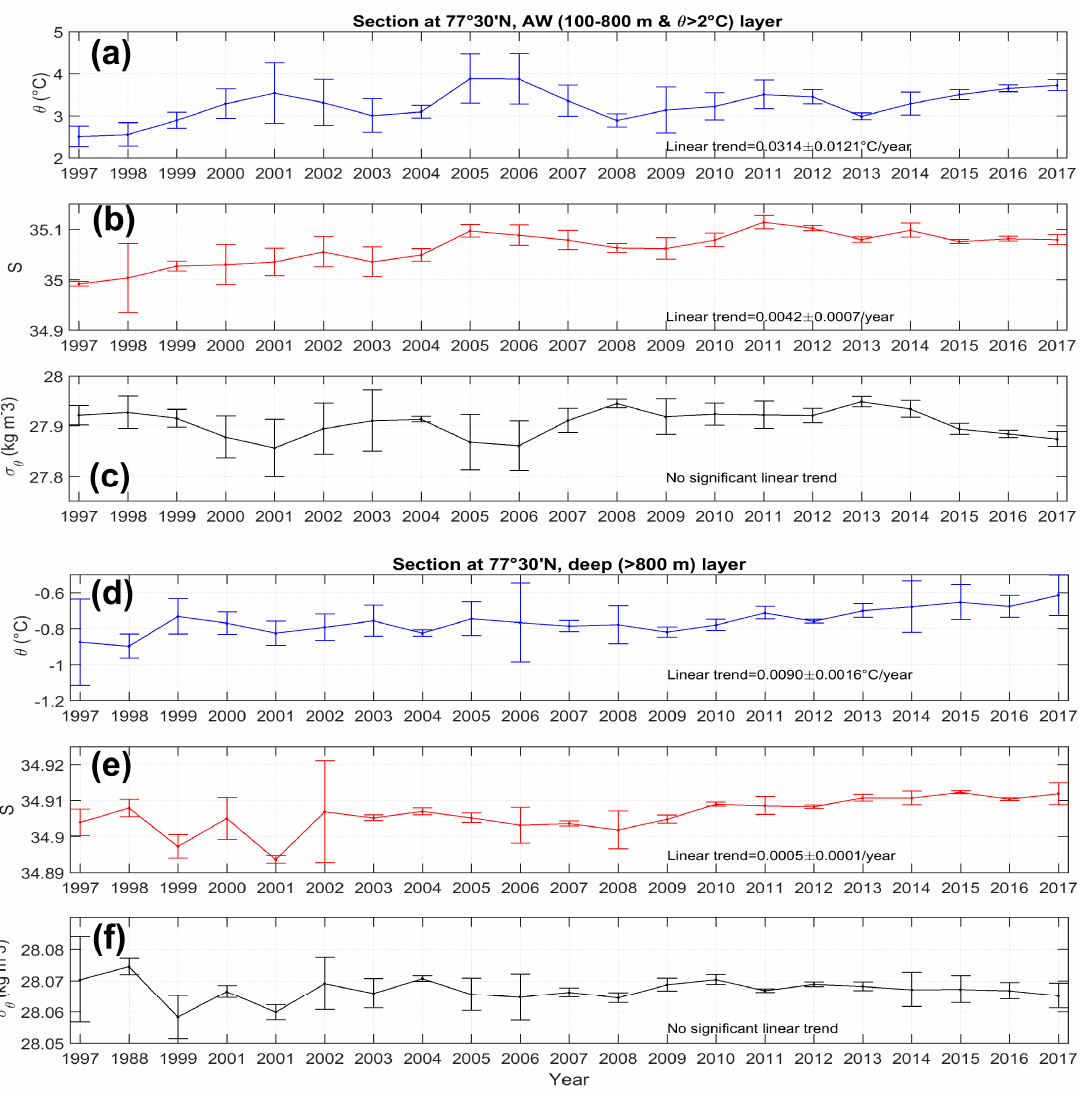
Figure 3. Weighted average of thermohaline properties ( θ , S, σ θ ) calculated from CTD stations along the section S at ~ 77°30 ′ N (between 8 and 10°30 ′ E, see Figure 1): upper layer ( a – c ) (100–800 m with θ > 2 °C) and deep layer ( d – f ) (>800 m). Weights are defined by the layer thickness at each station where bottom depth varied between 1000 and 2300 m. Data are from the hydrographic measurements carried out during summer AREX cruises aboard r / v OCEANIA